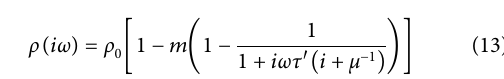
FIGURE 3 Representation oftheIPeffectsinthefrequencydomain.The waveformofthetransmittedcurrentandreceivedvoltageofCSEM with a transmitted fundamental frequency of 1 Hz with the IP effects. There is an obvious phase difference between the transmitting current and the receiving voltage, and the amplitude also decreases